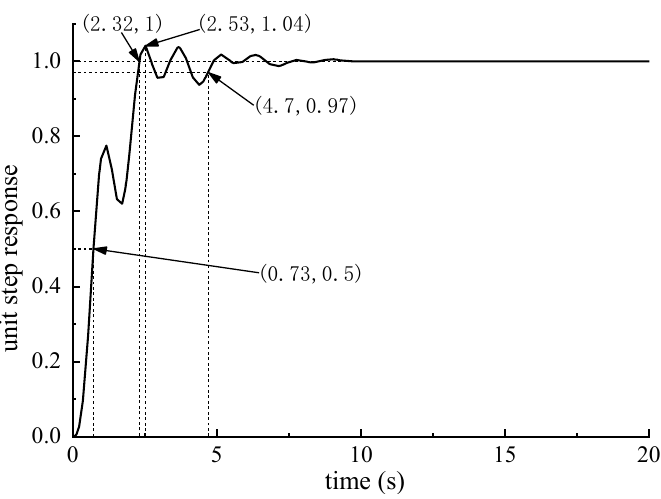
0 Figure 6. Simulation waveform of fuzzy PID control. Figure 6. Simulation waveform of fuzzy PID